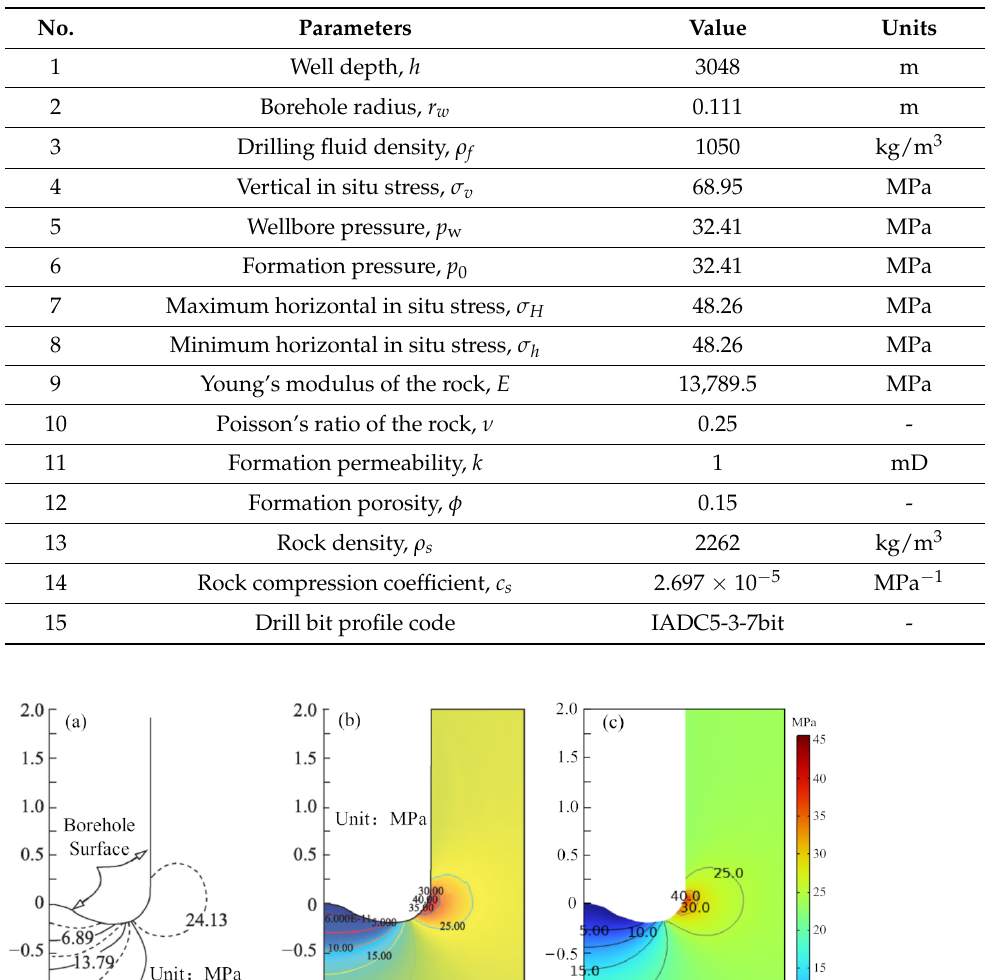
Table 1. Basic parameters of the Warren et al. model.